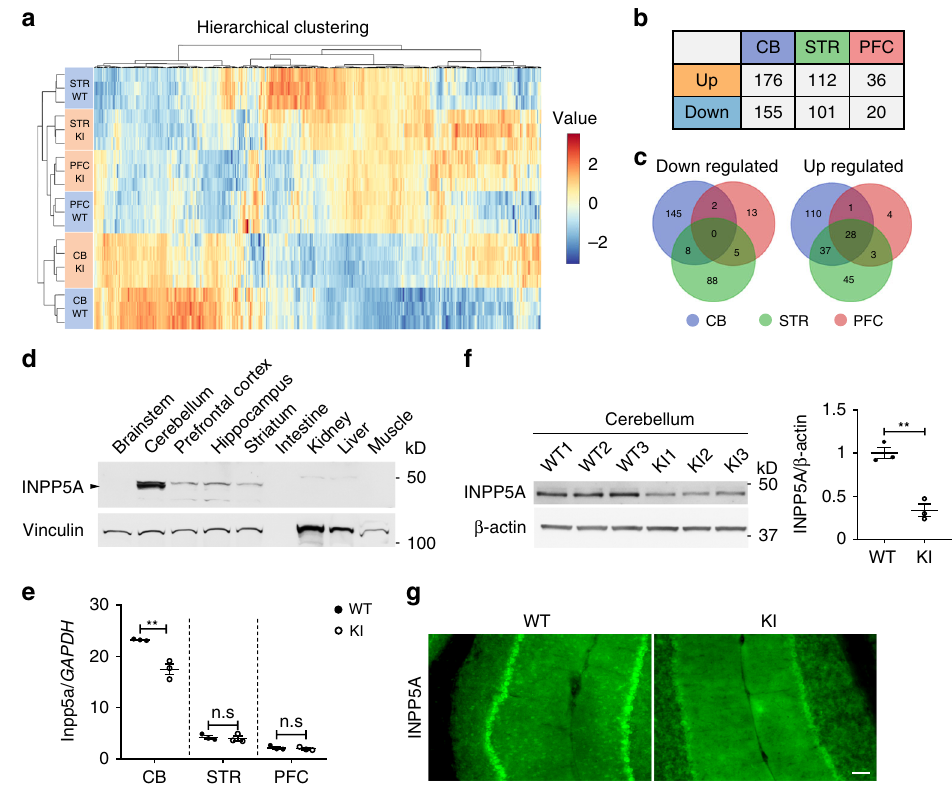
Fig. 4 Cerebellum-enriched INPP5A is downregulated in SCA17 knock-in mice. a Heatmaps of dysregulated genes hierarchically clustered from the cerebellum (CB), striatum (STR), and prefrontal cortex (PFC) of 3-month-old SCA17 KI and age-matched WT mice ( n = 3 – 4 mice per group). Data were presented as log2 fold change with adjusted P value < 0.05. b Summary of the numbers of differentially expressed genes in the CB, STR, and PFC in KI mice. c Venn diagrams indicating the numbers of downregulated or upregulated genes in the CB, STR, and PFC. d Western blotting of INPP5A levels in different tissues from 3-month-old WT mice. Vinculin was used as a loading control. e Real-time PCR assay of Inpp5a mRNA levels in the CB, STR, and PFC from 3-month-old KI mice. The relative mRNA levels of Inpp5a were obtained by normalizing values to an internal control, GAPDH , and analyzed with Student ’ s t test, t = 5.493, ** P = 0.0054, n = 3 mice per group. f , g Western blotting ( f ) and immuno fl uorescent staining ( g ) of INPP5A in the cerebellum from 3-month-old WT and KI mice. Scale bar = 100 μ m. In f , densitometric ratios of NeuN to β -actin were normalized to WT and analyzed with Student ’ s t test, t = 6.903, ** P = 0.0023, n = 3 mice per group. Data are represented as mean ± SEM. Source data and full blots are provided as a Source Data fi